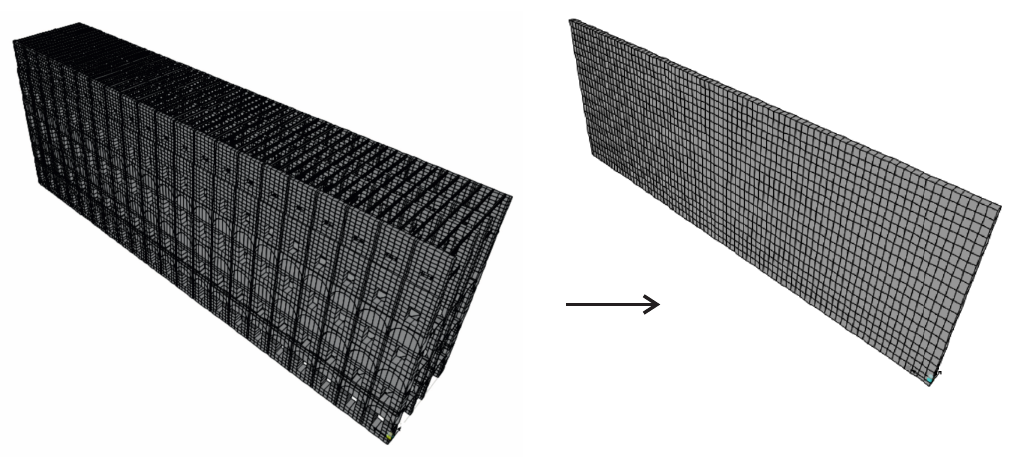
Figure 4. Homogenization